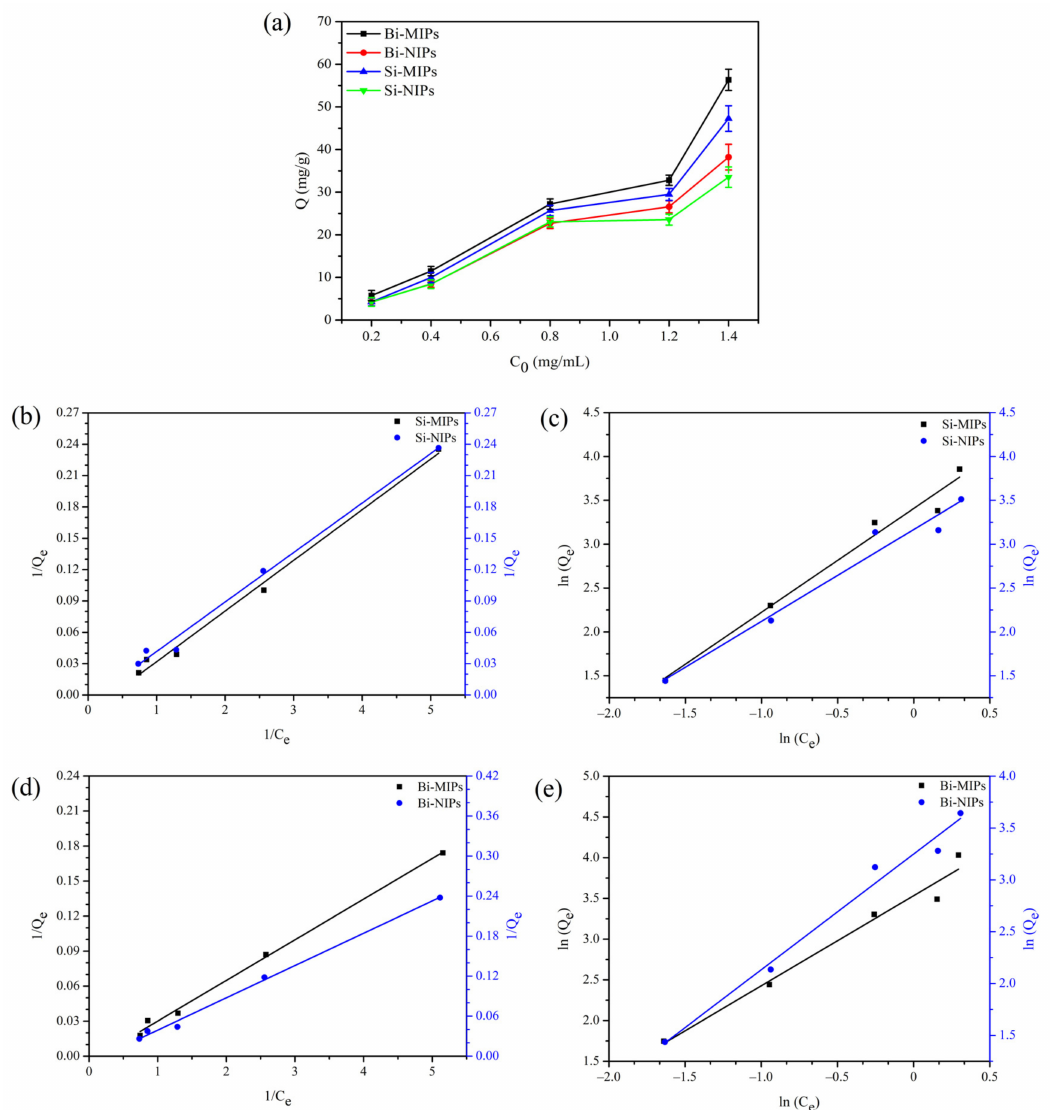
Figure 4. ( a ) Adsorption isotherm of the Bi-MIPs, Bi-NIPs, Si-MIPs and Si-NIPs; ( b ) Langmuir adsorption isotherm of the Si-MIPs and Si-NIPs; ( c ) Freundlich adsorption isotherm of the Si-MIPs and Si-NIPs; ( d ) Langmuir adsorption isotherm of the Bi-MIPs and Bi-NIPs; ( e ) Freundlich adsorption isotherm of the Bi-MIPs and